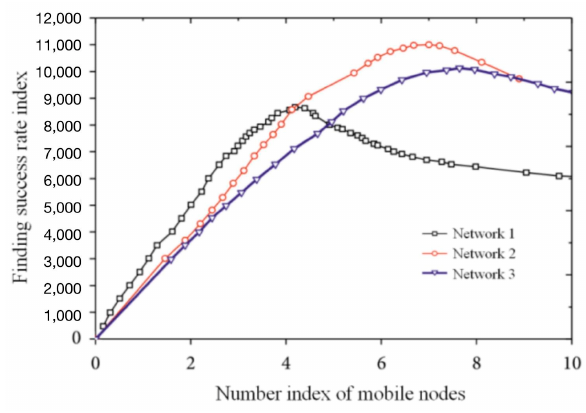
Figure 8. Perceived service node search success rate.